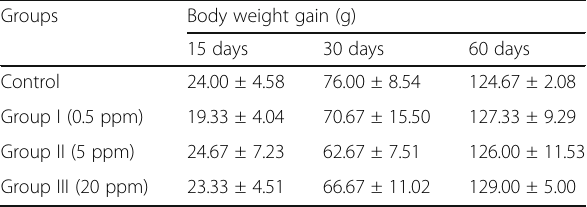
Table 1 Comparison of body weight gain of rats exposed to 0, 0.5, 5 and 20 ppm fluoride for 15, 30 and 60 days. Data are expressed as mean ± S.D., ( n =